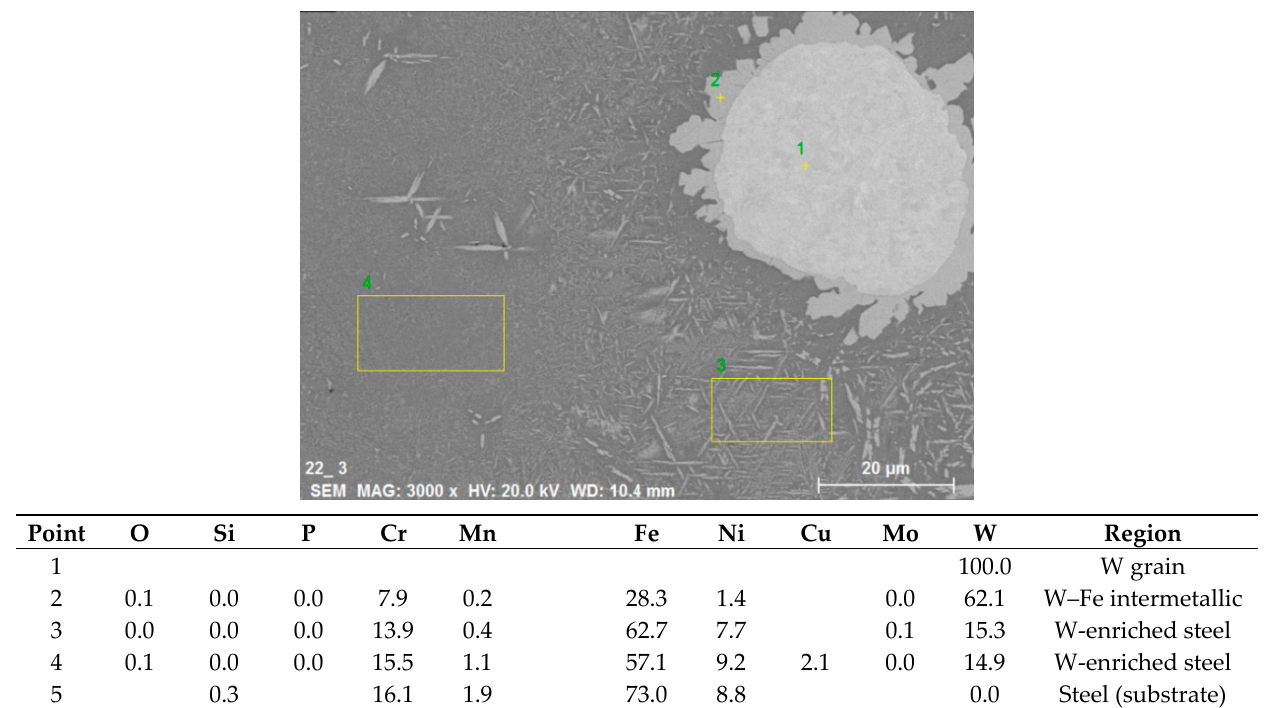
Figure 8. Results of local EDS analysis on the cross section of 75% W sample on a steel substrate.